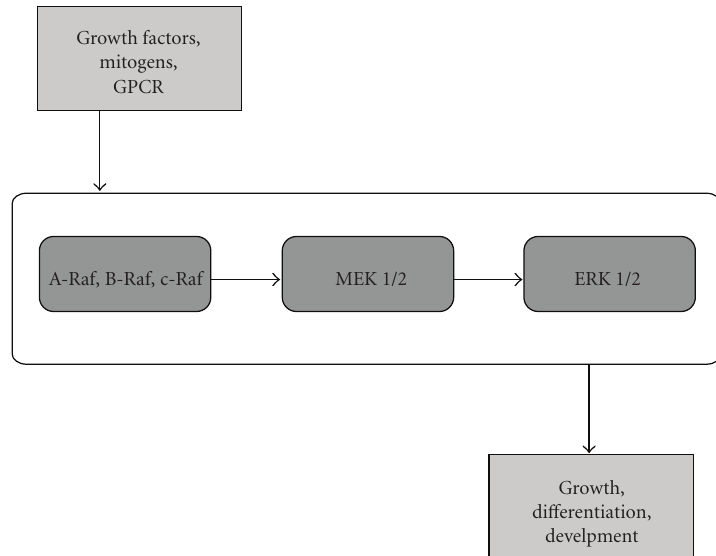
Figure 3: Activation of MEK 1/2 and ERK 1/2 by MAP3K. The phosphorylation (i.e., activation) of A-Raf, B-Raf or c-RAF, by MAPKKK (i.e., MAP3K) results in MAP2K-mediated phosphorylation of MEK 1/2 and downstream activation of ERK 1/2 (reviewed in